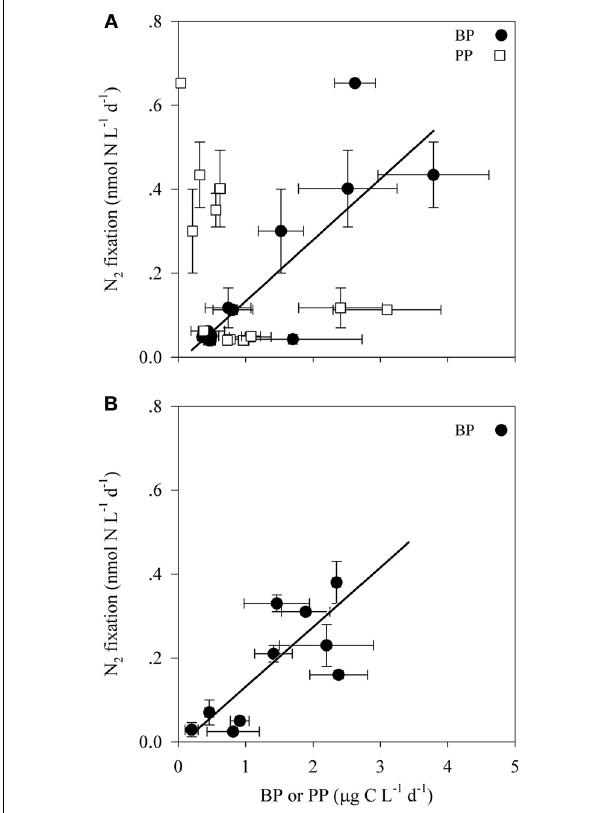
FIGURE 2 | The relationship between N 2 fixation and primary and bacterial productivity within the photic (A) and aphotic (B) layers of the LB and GA stations. Values are averages and error bars are standard deviations of three independent replicates performed for each control and treatment incubation.